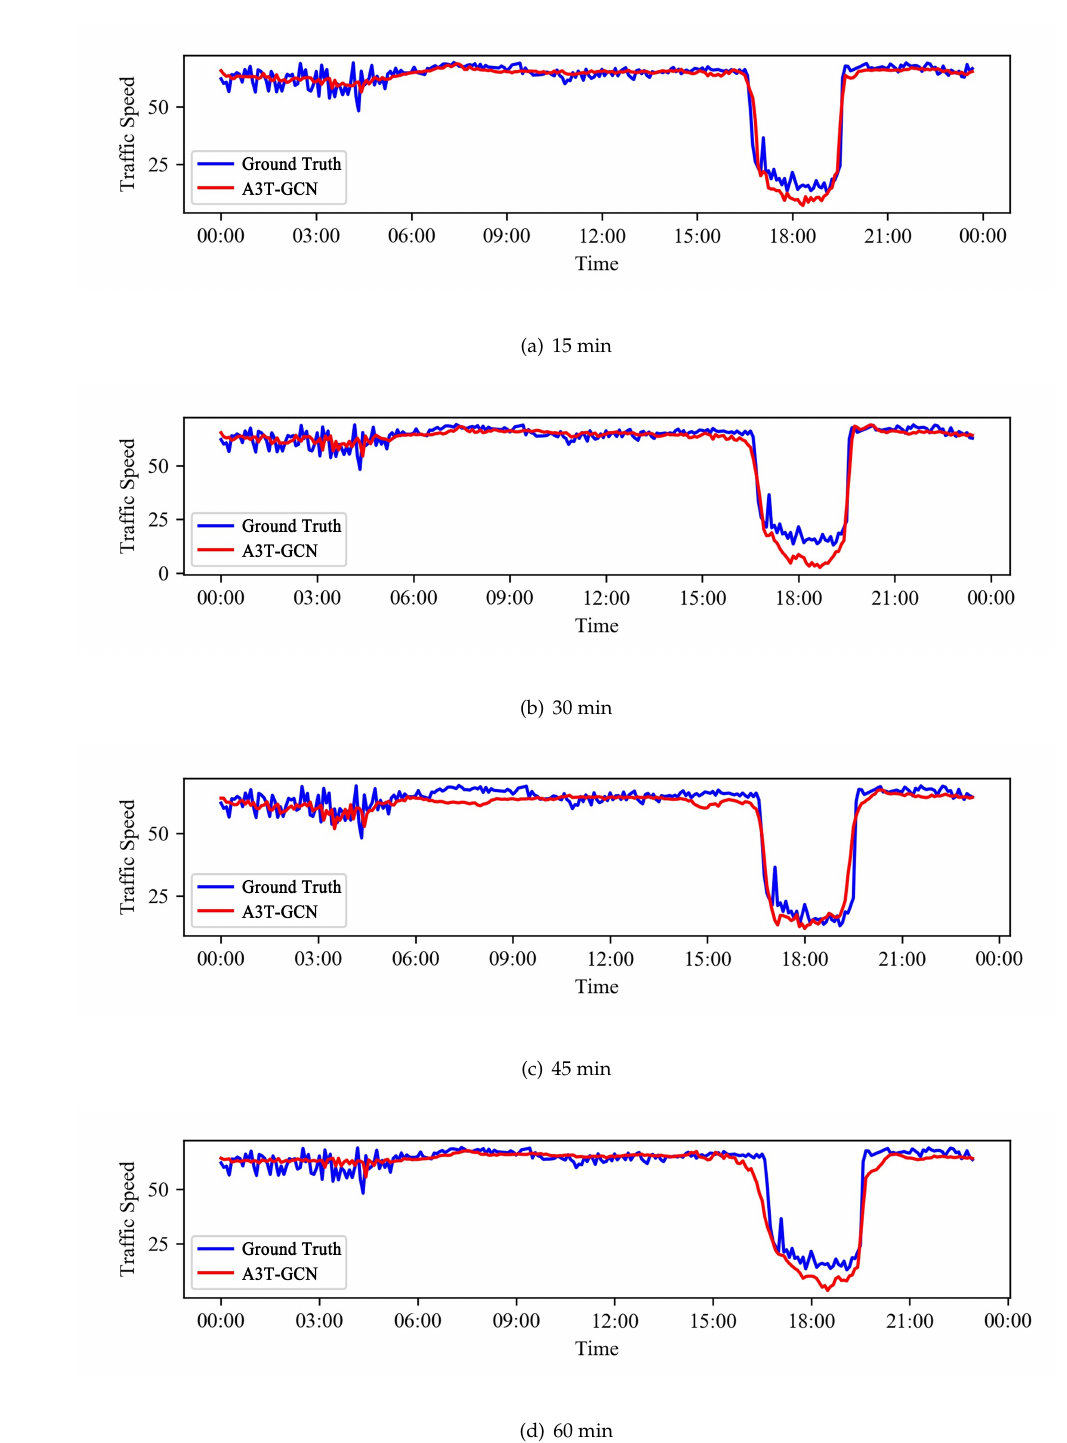
Figure 9. The visualization results for prediction horizon of 15, 30, 45, 60 min